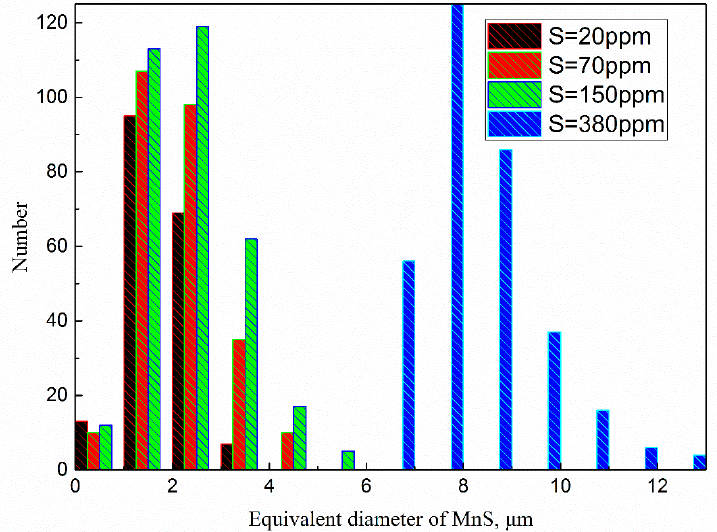
Figure 4. Size distributions of MnS in different steel samples.